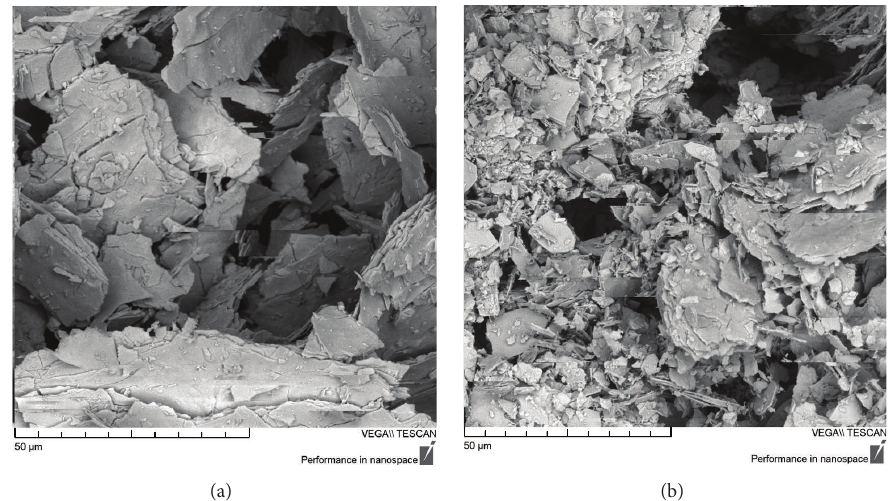
Figure 1: SEM images of cerium carbonate (a) and CeO 2 annealed at 400 ∘ C (b).